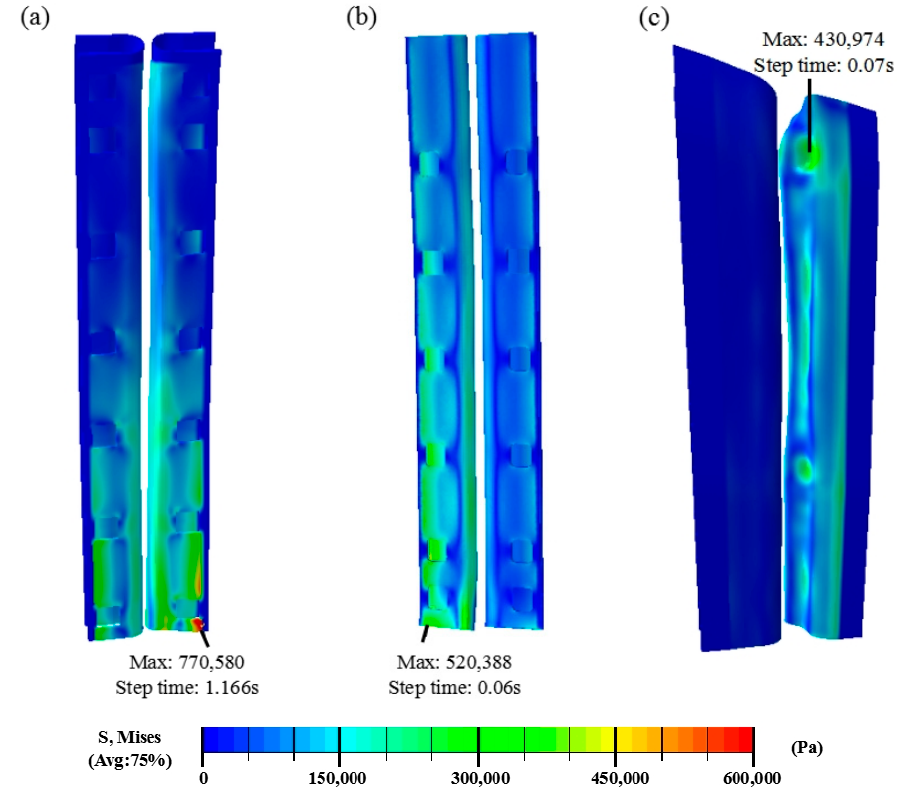
Figure 19. Stress concentration location: ( a ) Case 1, ( b ) Case 2, ( c ) Case 3.